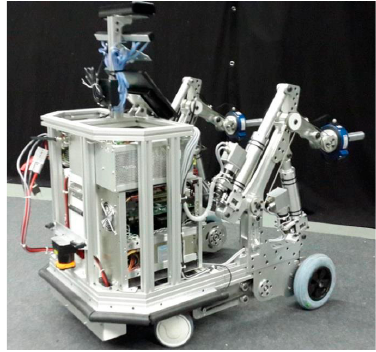
Figure 1. The MOBOT rollator-type robotic mobility assistant.